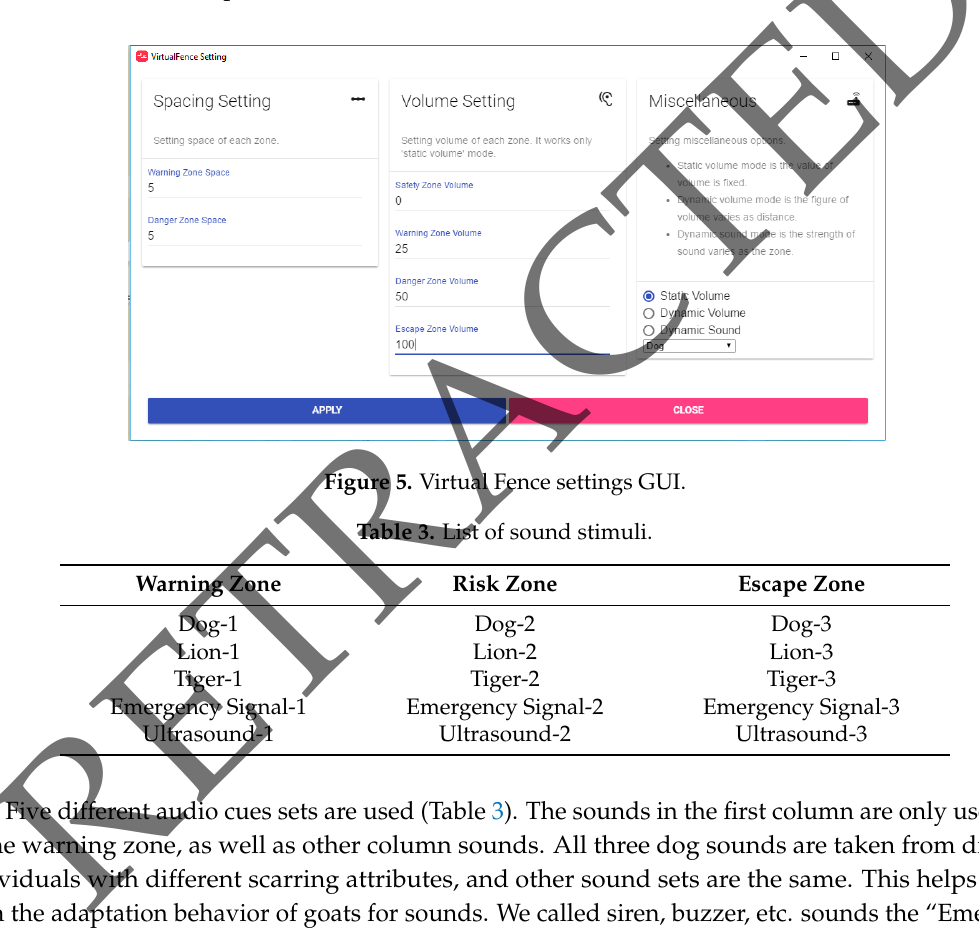
Figure 5. Virtual Fence settings GUI. Table 3. List of sound